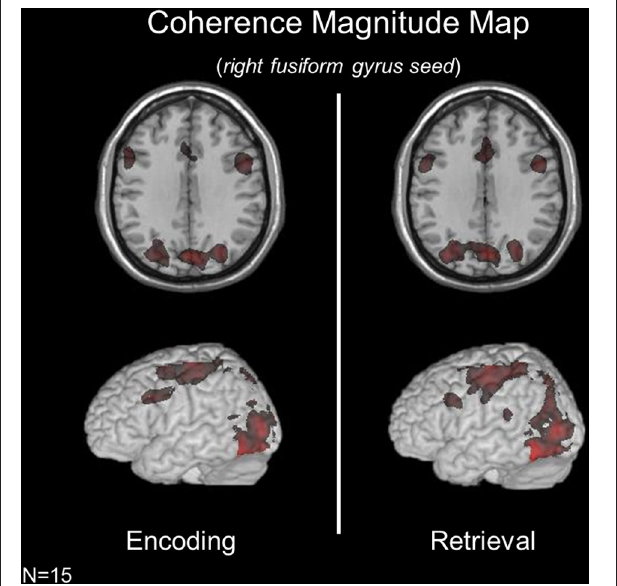
FIGURE 2 | Coherence magnitude analyses using a right fusiform gyrus seed across memory conditions revealed highly overlapping networks during encoding and retrieval.